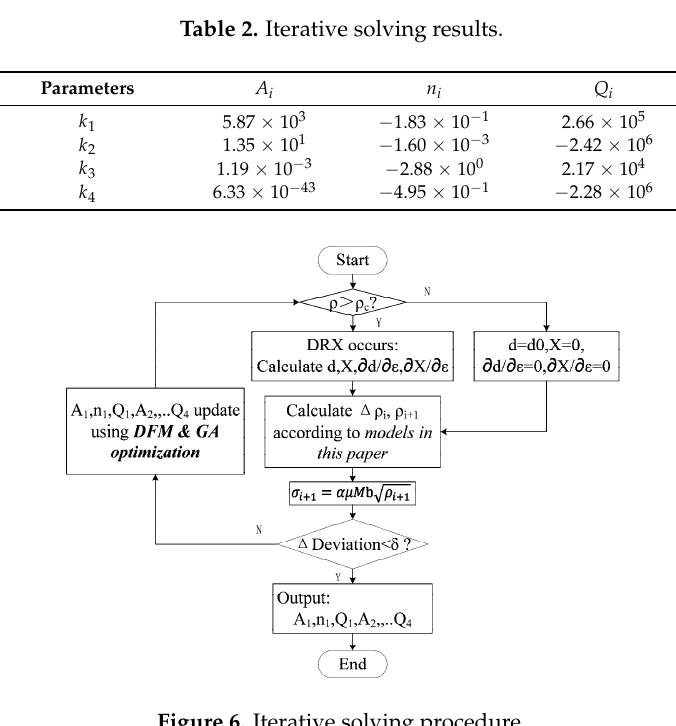
Figure 6. Iterative solving procedure.